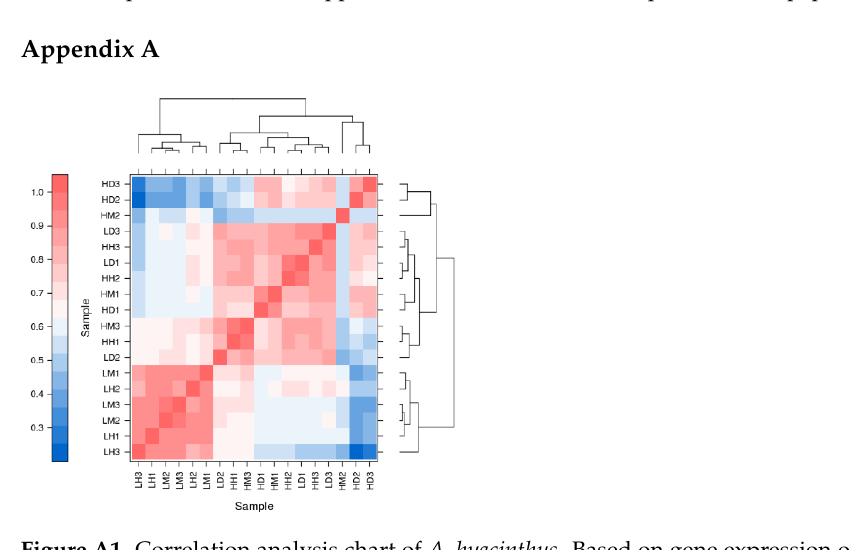
chemistry data for all treatments. Table S2: qPCR Primer sequences. Table S3: Data of various physiological indicators. Table S4: Two way ANOVA output of different variables for A. hyacinthus with bold values indicating significant effects on the variable. Table S5: Statistics summary of RNA- Seq of A. hyacinthus. Table S6: DEGs statistics in all treatments. Table S7: FPKM expression map of different biological processes regulated by DEGs. Table S8: The log 2 FoldChange value of qRT-PCR and RNA-seq. Table S9: Distribution of gene ontologies which were signifificantly enriched in KEGG pathways of LH, LM, HD, HH and HM treatments.